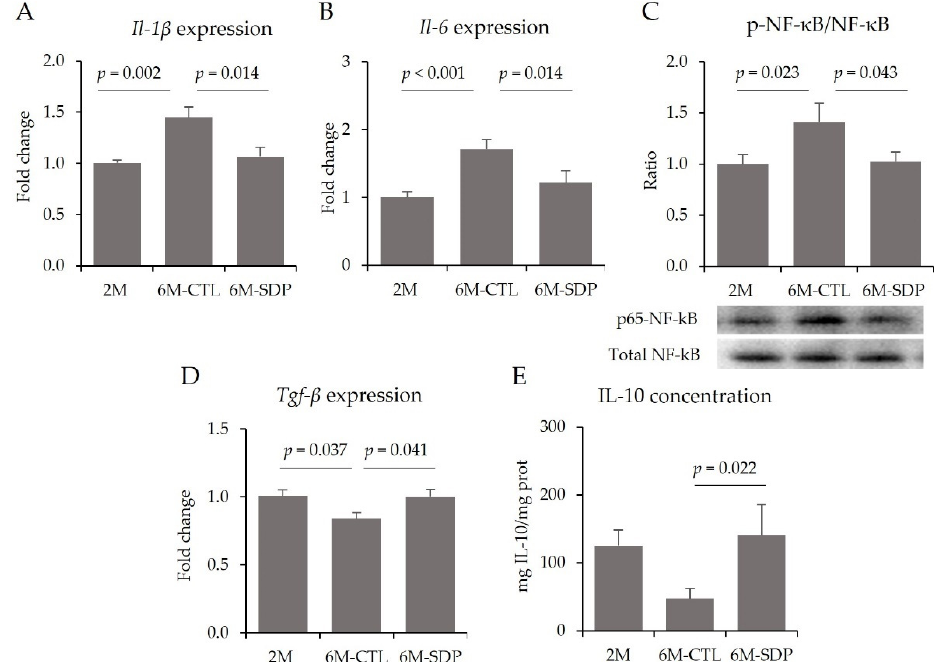
Figure 5. Neuroinflammation in cortical tissue. Gene expression of Il-1 β ( A ) and Il-6 ( B ), protein abundance of p65-NF- κ B respect to total NF- κ B ( C ), gene expression of Tgf- β ( D ), and concentration of IL-10 ( E ). Results are expressed as mean ± SEM ( n = 8–9 mice/group). Statistics: ANOVA (Fisher multiple comparison test). Il, interleukin; NF- κ B, nuclear factor kappa-light-chain-enhancer of activated B cells; Tgf- β , transforming growth